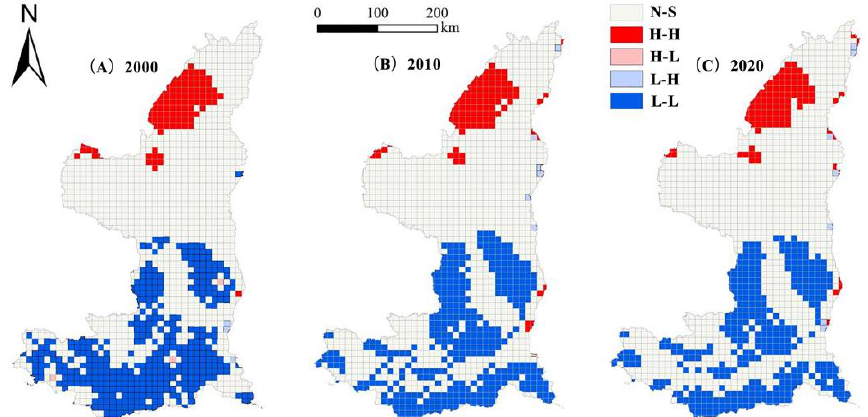
Figure 8. Local spatial autocorrelation distribution map of landscape ecological risks in the Yellow River Basin in Shaanxi Province from 2000 to 2020.